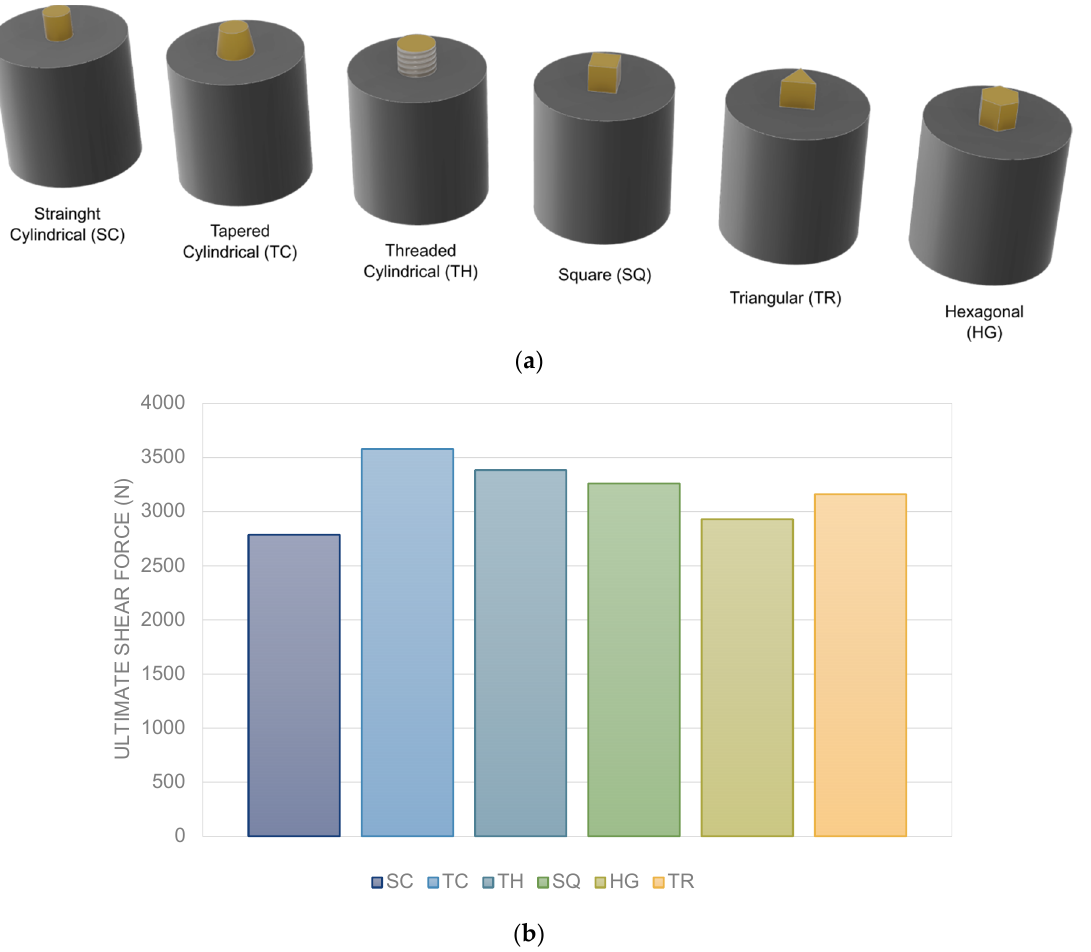
Figure 35. Influence of the tool probe shape on the mechanical behavior of the welds (data extracted from [86]). ( a ) pin shapes and ( b ) effect of pin shape on the UTS of the joint. Materials 2020 , 13 , x FOR PEER REVIEW